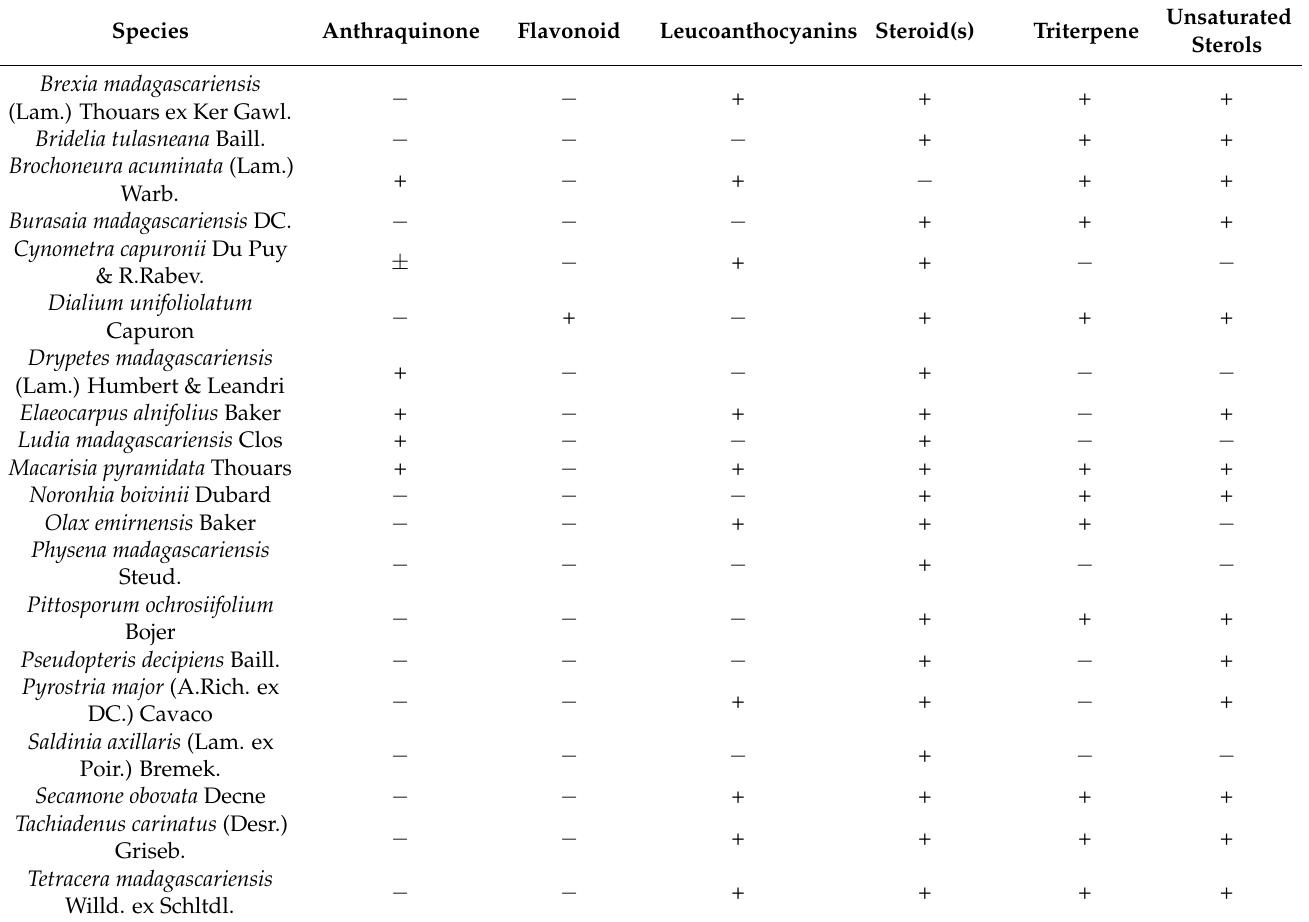
Table 5. Secondary metabolites present in the leaf samples. (+: Present; − : Absent; ± : Trace) ( Continuation of Table 4). Species Brexia